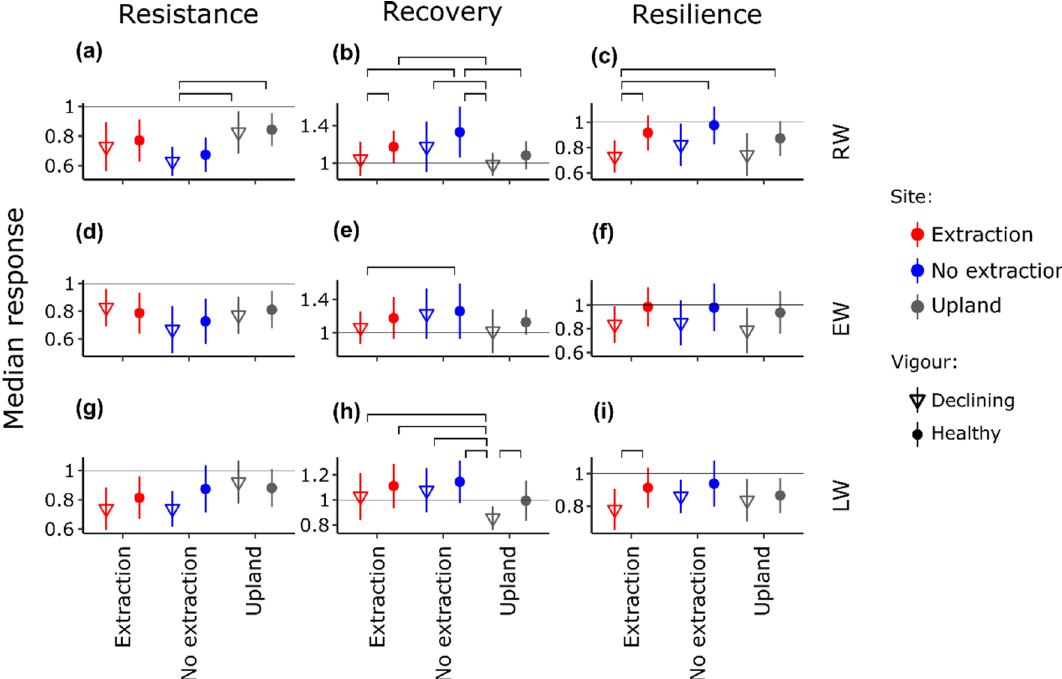
Figure 6. Median components of resilience (resistance: ( a ), ( d ) and ( g ); recovery: ( b ), ( e ) and ( h ); and resilience: ( c ), ( f ) and ( i ) for ring width variables (ring-width (RW); earlywood width (EW); latewood width (LW)) of trees at different sites (red for extraction, blue for no extraction and grey for upland sites). Points denote healthy trees and triangles declining trees. Bars denote median absolute deviation. Brackets connect statistically significant different groups ( p < 0.05).